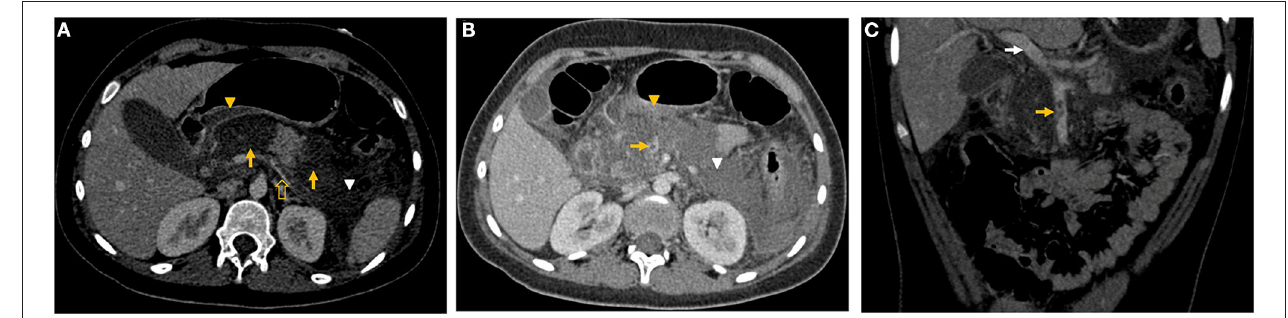
FIGURE 1 | (A) Axial CECT view showed 80% parenchymal necrosis, affecting head, neck and tail (yellow arrows), APFC adjacent to pancreatic head (yellow arrowhead) and in left anterior pararenal space (white arrowhead), and nonocclusive SplVT (yellow hollow arrow). (B) Nonocclusive SMVT (yellow arrow), APFC adjacent to pancreatic head (yellow arrowhead) and in left anterior pararenal space (white arrowhead) are shown. (C) Coronal CECT view of non-occlusive SMVT (yellow arrow), and normal portal vein (white arrow).